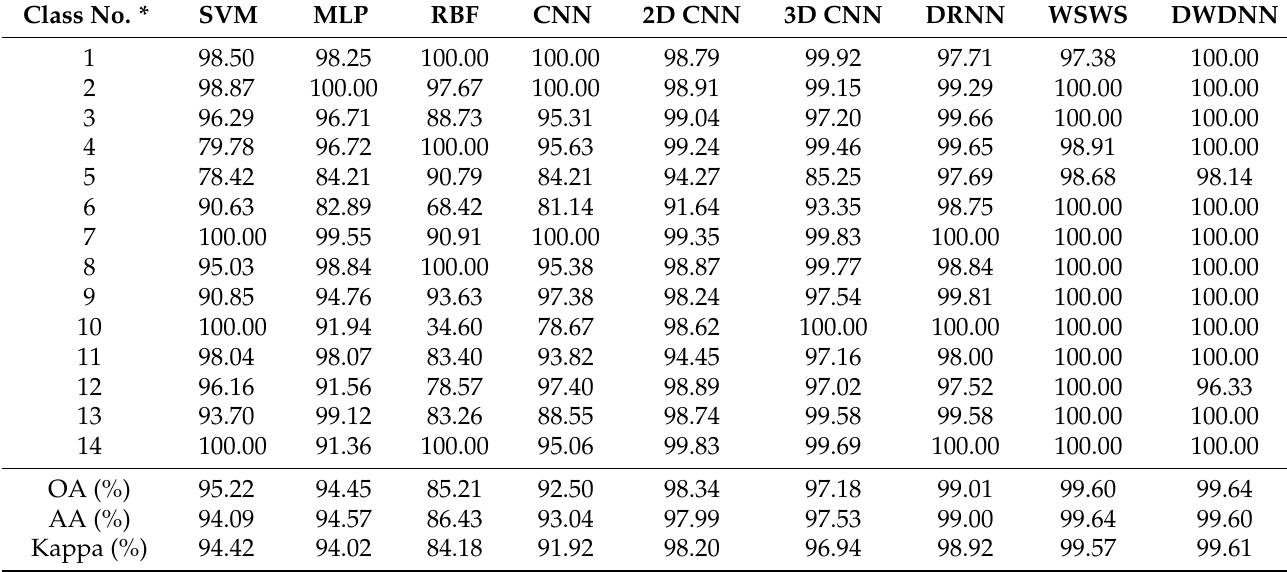
Table 3. Classification results of different methods on the Botswana